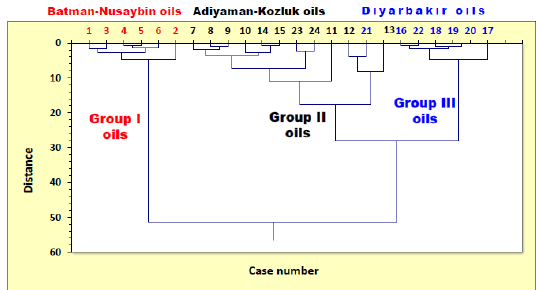
Figure 3. A dendogram showing the genetic grouping of the SE-Turkey crude oils. The dendogram is based on the 24 crude oils and 8 source specific variables. Oil numbers from 1 to 24 correpond the oil sample numbers in Fig.1